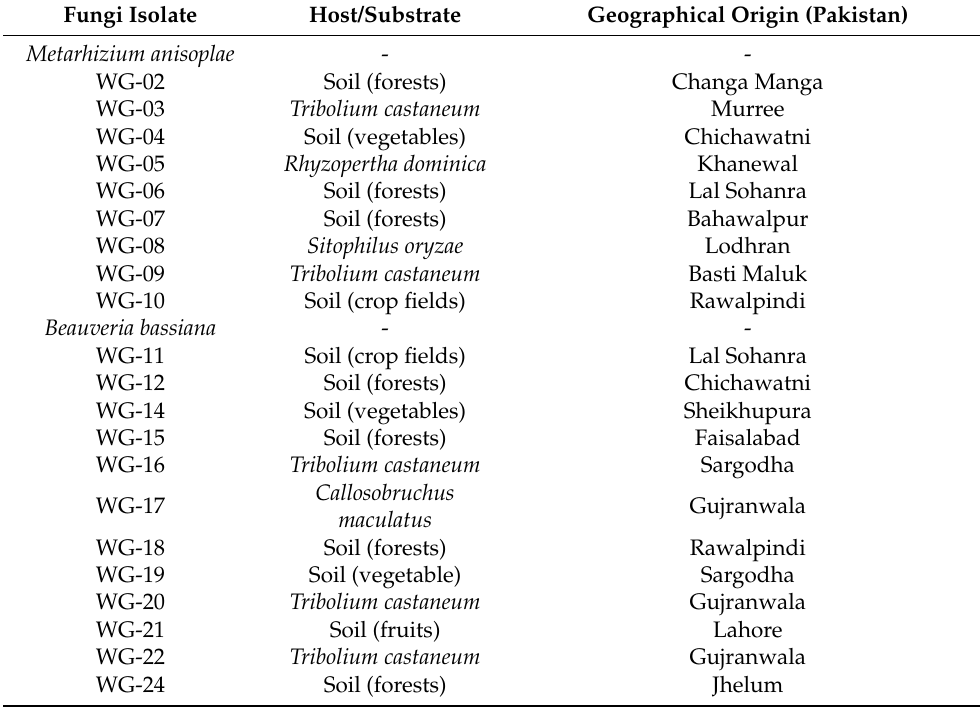
Table 1. Sources of entomopathogenic fungi that were isolated and evaluated against B. zonata and B. dorsalis